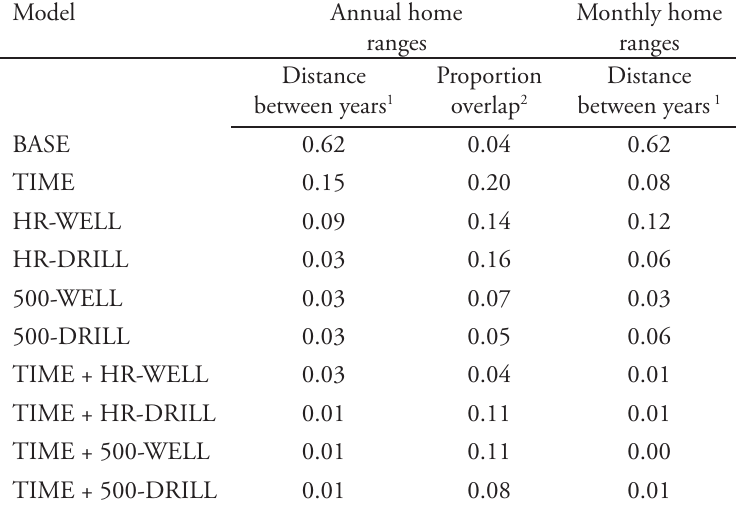
Table 1. Akaike weights for the ten models based on mean response for each of the fidelity measures used to assess if boreal woodland caribou ( Rangifer tarandus caribou ) abandoned monthly and annual home ranges in response to industrial activity in the West Side Athabasca River Caribou Range (WSAR). The higher the value in the model set the better the fit of the model to the data relative to other models in that set. Note: in text, prefixes “A” and “M” were added to measures (e.g. “ A HR-WELL” is the total number of wells in an annual home